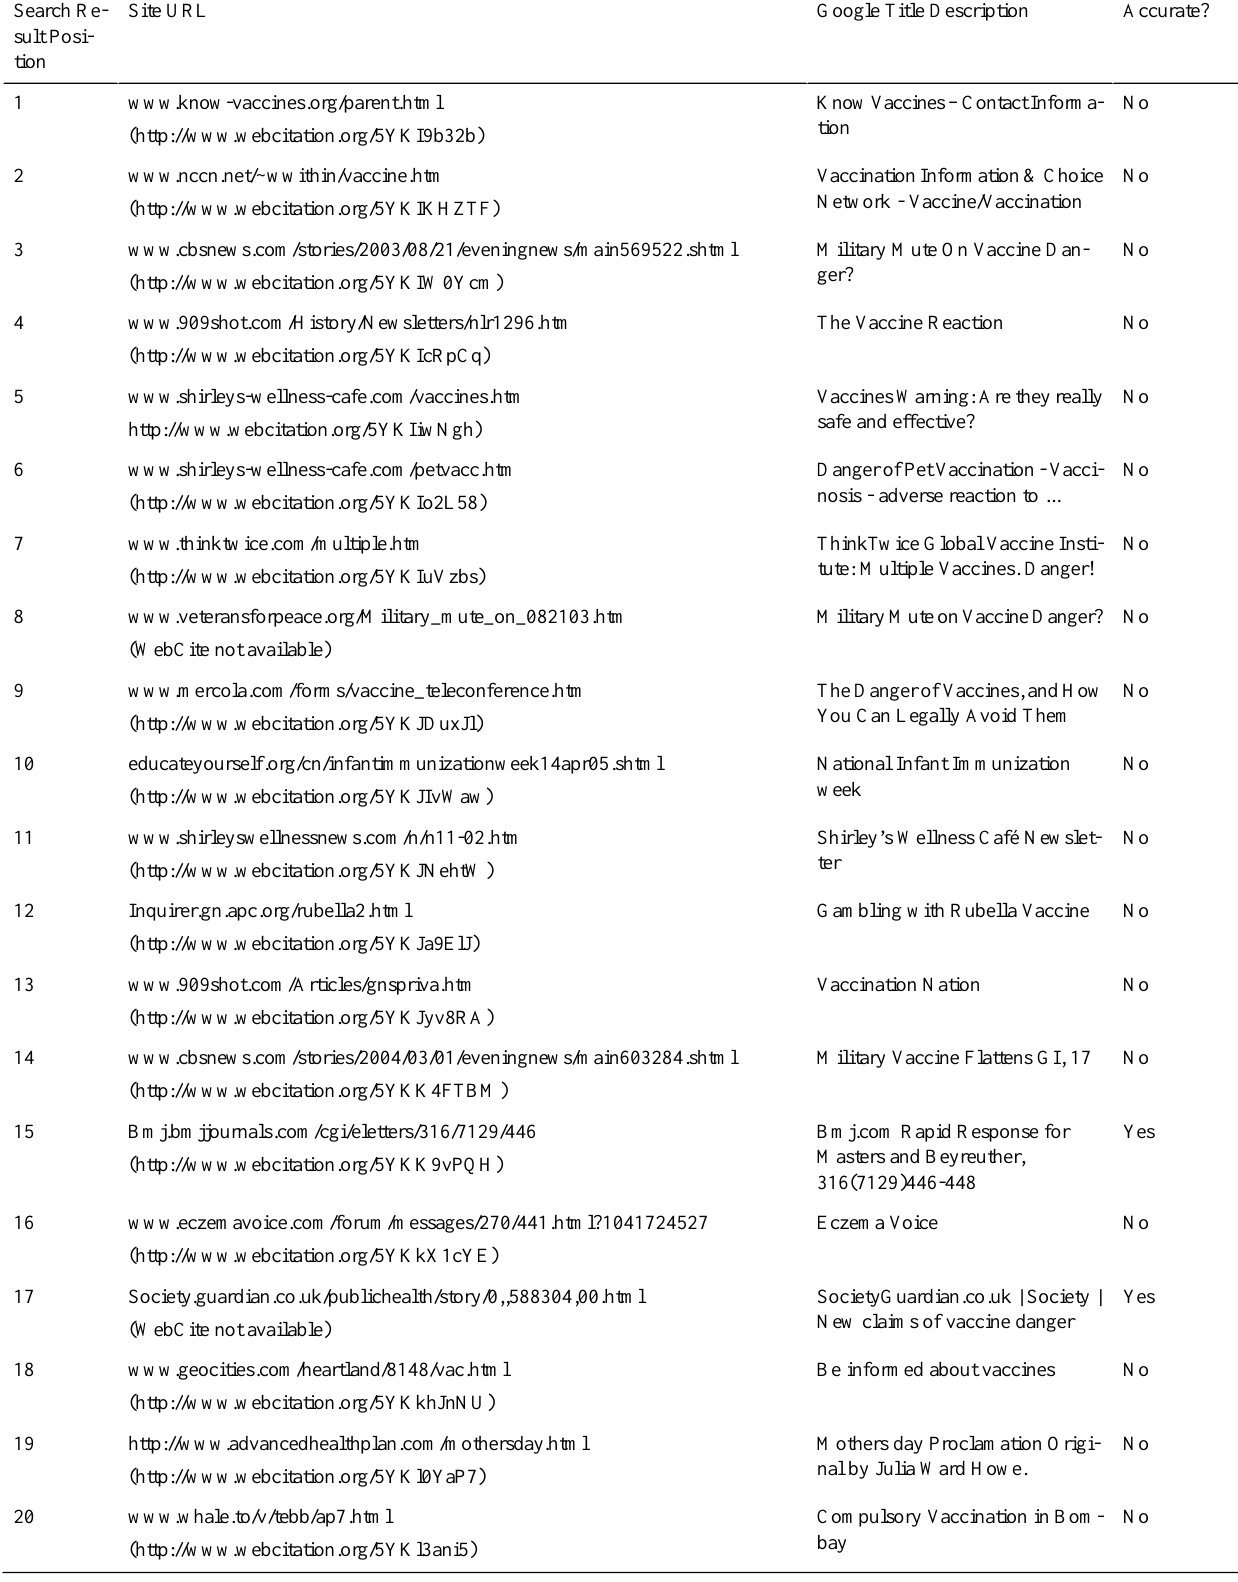
Accurate?Google Title DescriptionSite URLSearch Re-